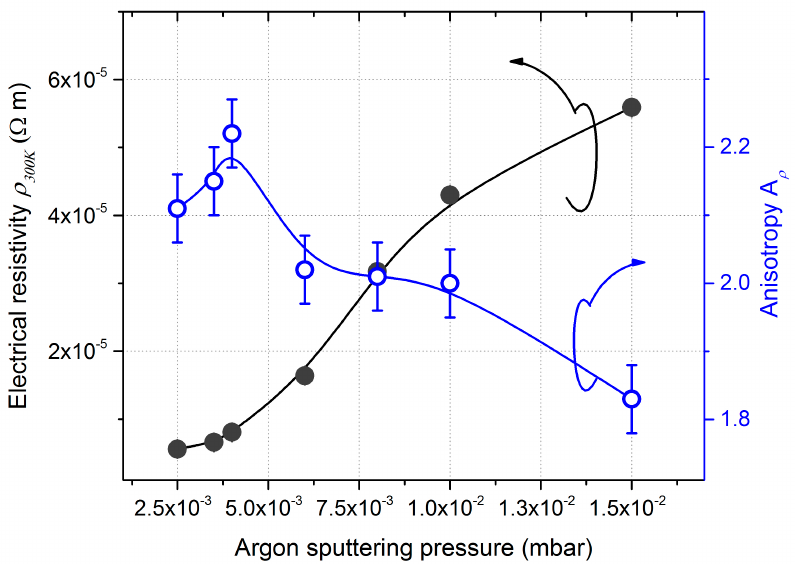
Figure 8. DC electrical resistivity and anisotropic resistivity measured at room temperature (300 K) vs. argon sputtering pressure of 400 nm thick W GLAD thin films prepared on a glass substrate with a deposition angle α = 80°.